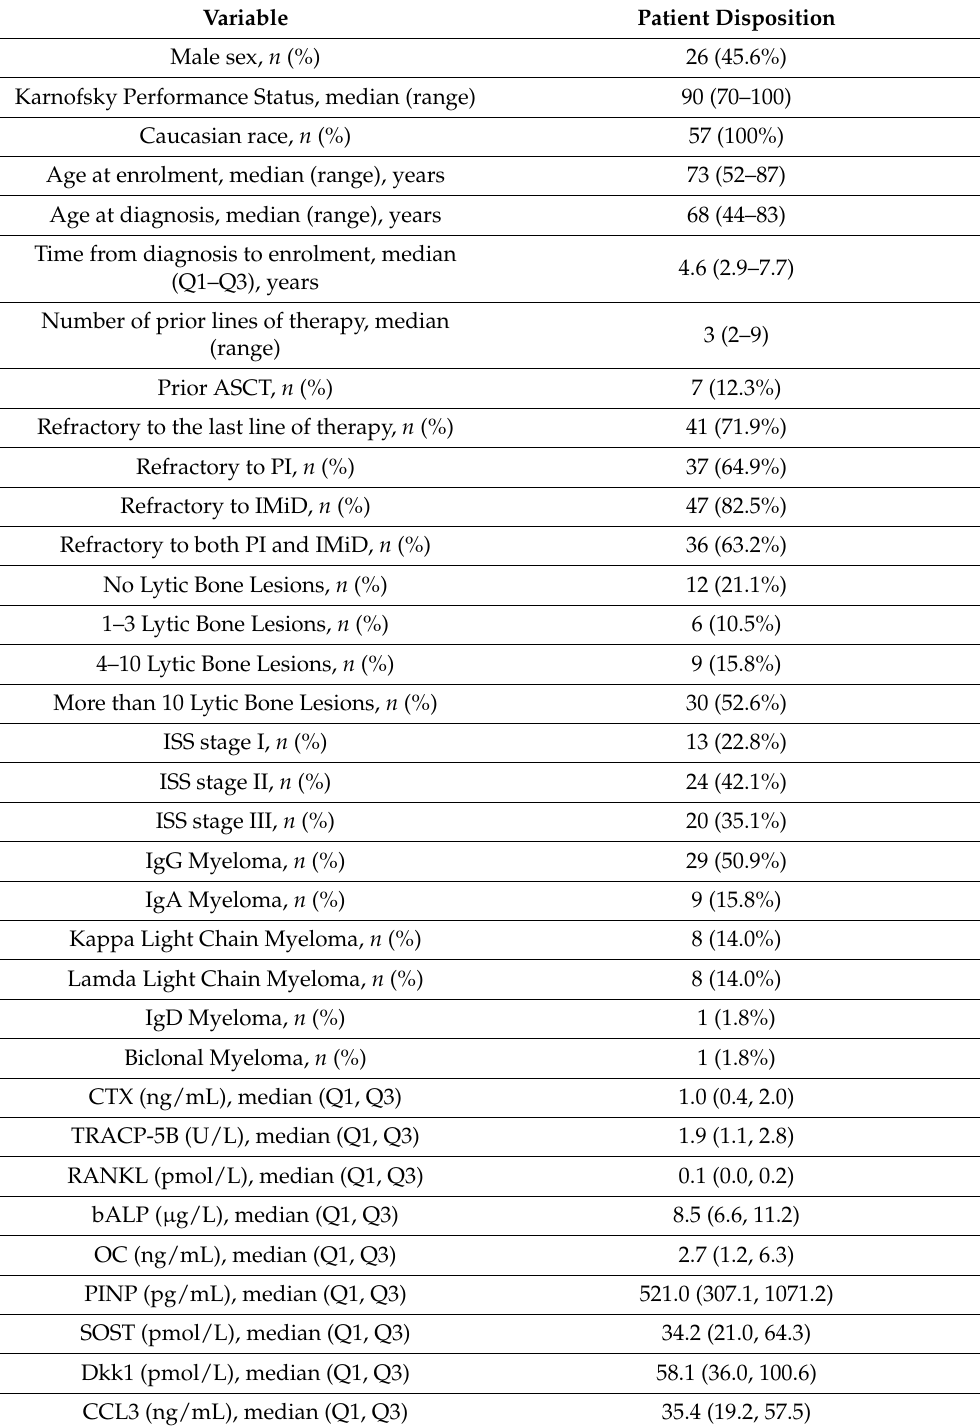
Table 1. Baseline characteristics of 57 enrolled